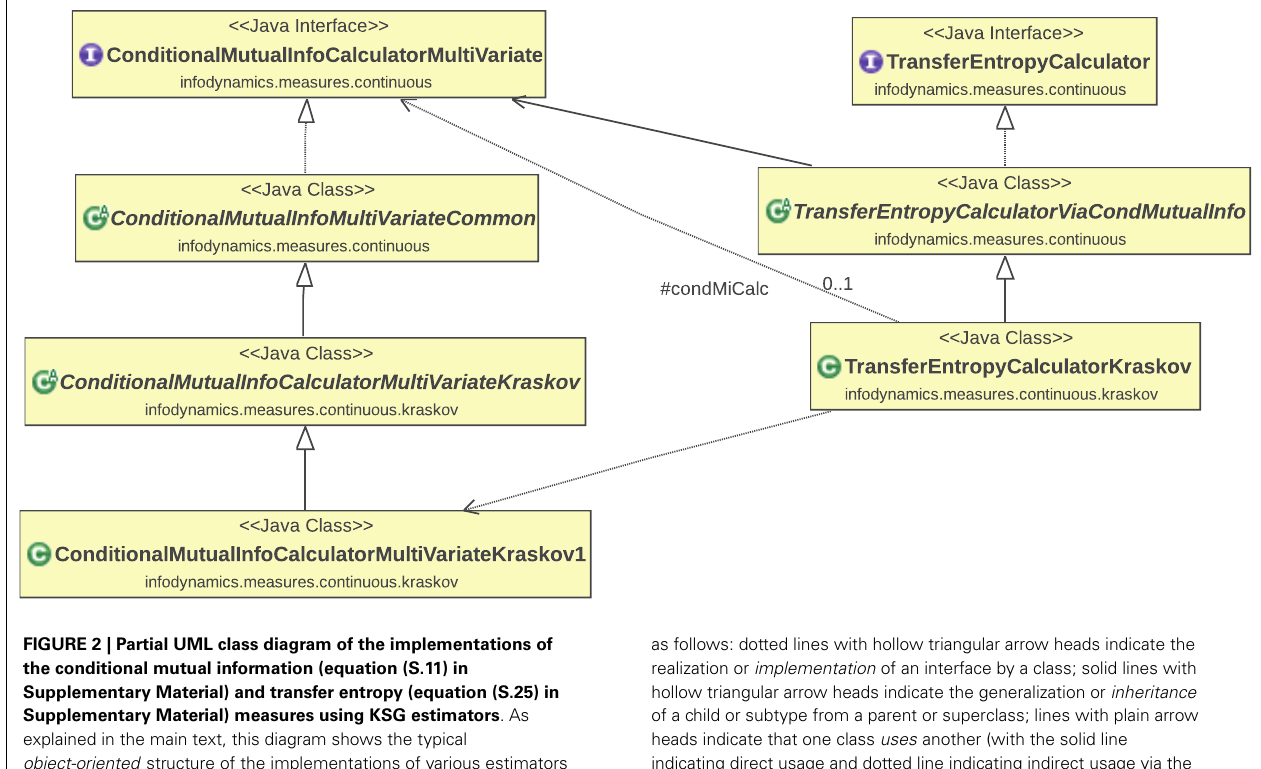
FIGURE 2 | Partial UML class diagram of the implementations of the conditional mutual information (equation (S.11) in Supplementary Material) and transfer entropy (equation (S.25) in Supplementary Material) measures using KSG estimators . As explained in the main text, this diagram shows the typical object-oriented structure of the implementations of various estimators for each measure.The relationships indicated on the class diagram are